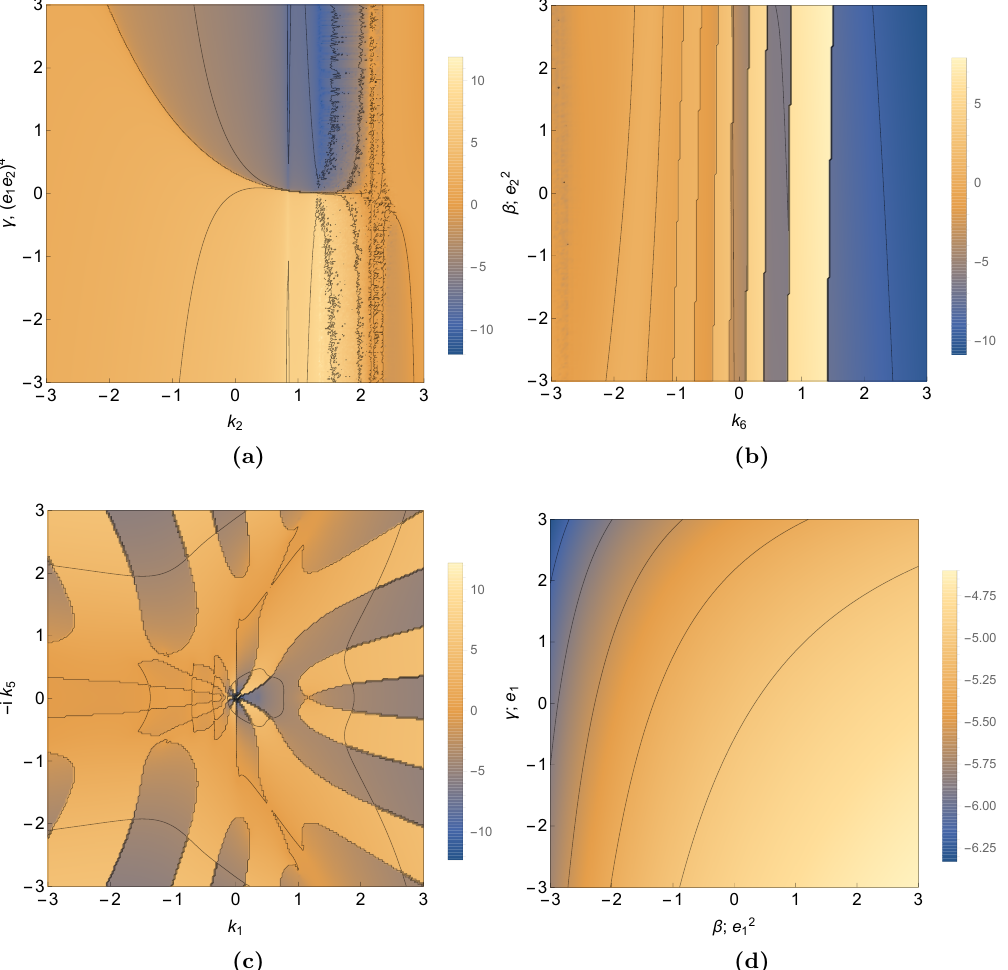
Figure 1 . Dependence of Yukawa eigenvalues’ ratio log j r j on the complex structure moduli. While we use the labels k i for the parameters of (cid:14) and d 3 introduced in (3.40), we indicate the others by the corresponding monomial in the polynomials ( (cid:12) or (cid:13) ). In, (a) and (b), we vary one modulus in d 3 =(cid:14) and one in (cid:12)=(cid:13) . In (c), we vary parameters in d 3 =(cid:14) only, e(cid:11)ectively just moving around the two Yukawa points. For (d), we only vary parameters in (cid:12) and (cid:13) . The results suggest that varying the parameters controlling the Yukawa points a(cid:11)ect the ratio more drastically than those in (cid:12) and (cid:13) , unless we modify the coe(cid:14)cients of the high-degree terms in the latter. These plots were generated in Mathematica and su(cid:11)er from some numerical instabilities, which do not qualitatively change our